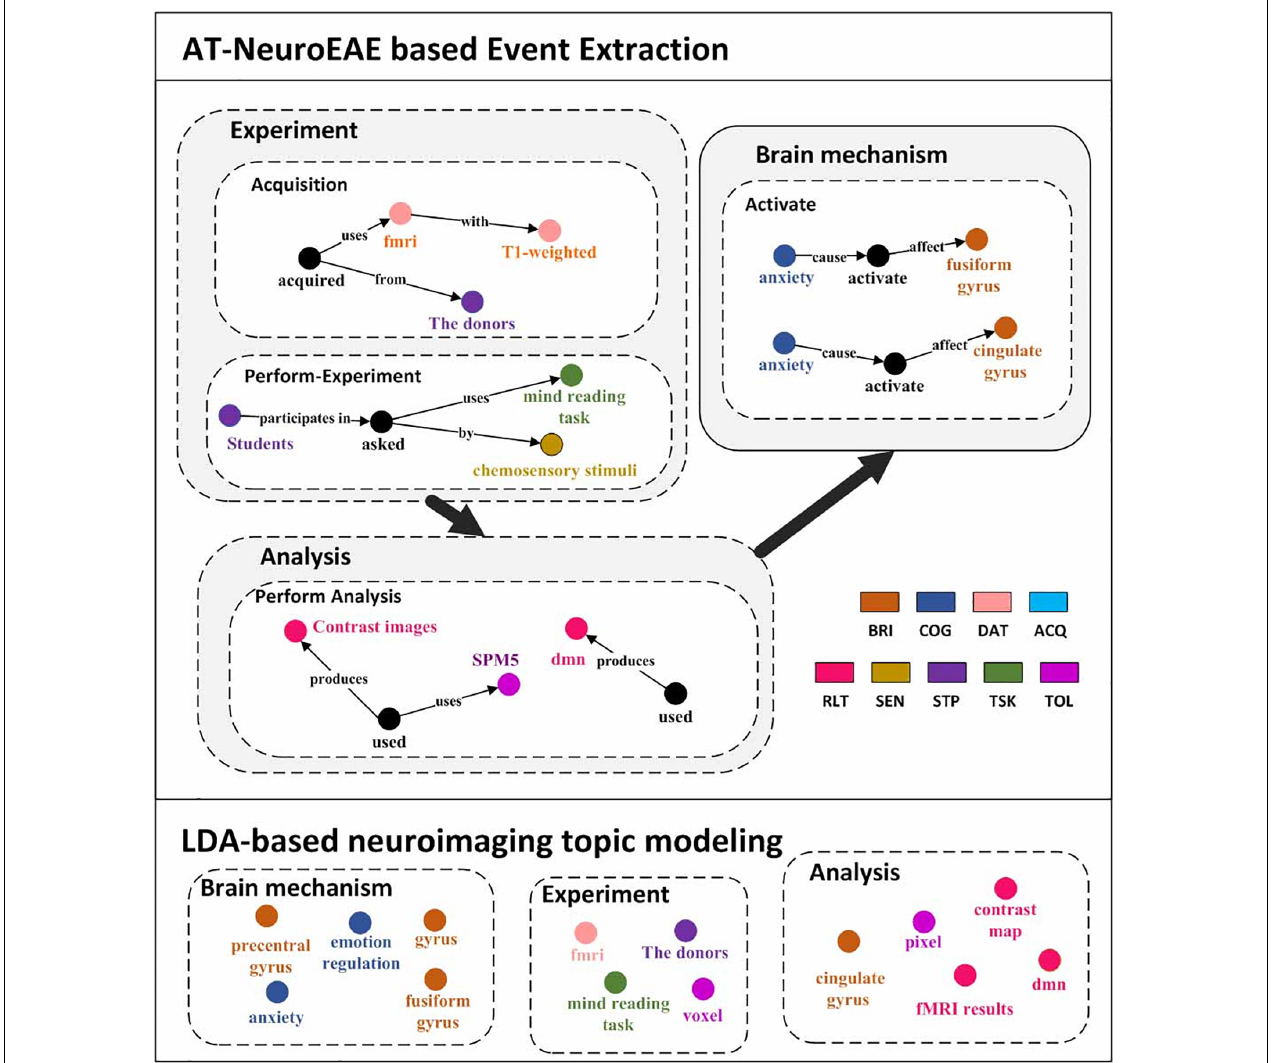
FIGURE 7 | Visualization results of event extraction. The top is five events extracted from the article (Prehn-Kristensen et al., 2009). The bottom is LDA topics extracted from the same article. In order to compare with the results of AT-NeuroEAE, LDA topics are manually divided into three classes, brain mechanism, experiment, and